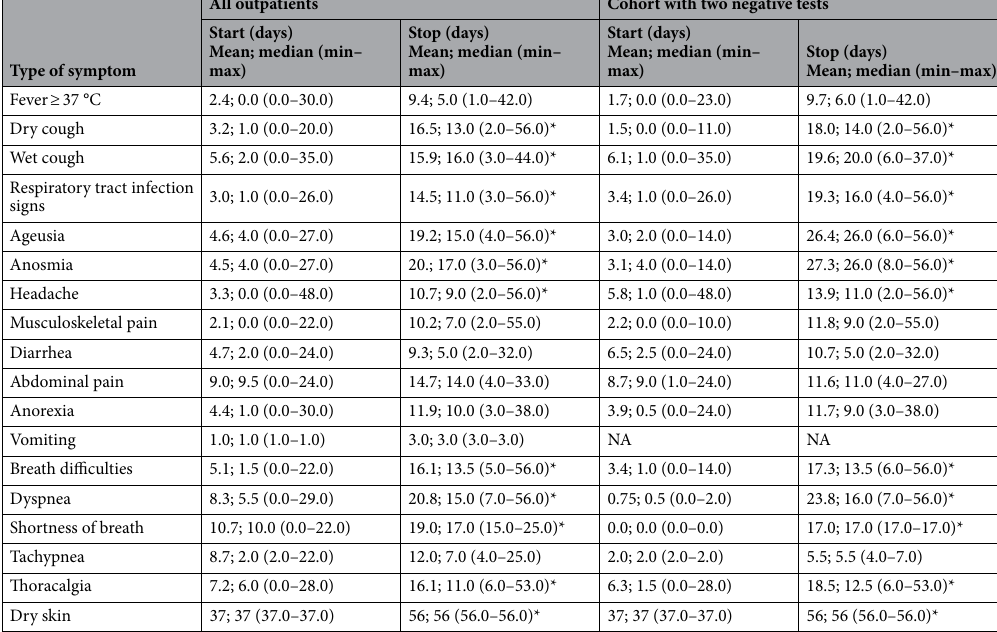
Table 5. Symptoms’ onset during COVID-19. For each patient, day 0 was determined either as the day of first symptom onset, or the day of the first positive sample, whichever came first, although the majority of patients generally had symptoms before the first positive test (see Fig. 6). Six completely asymptomatic patients are not included in this Table. COVID‑19 coronavirus disease-19, NA not applicable. a Symptom continued on the last phone call at least in one patient. Telemonitoring was ended due to double PCR negative testing.